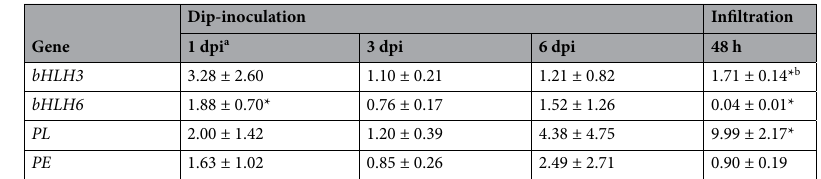
Dip-inoculation Infiltration Gene 1 dpi